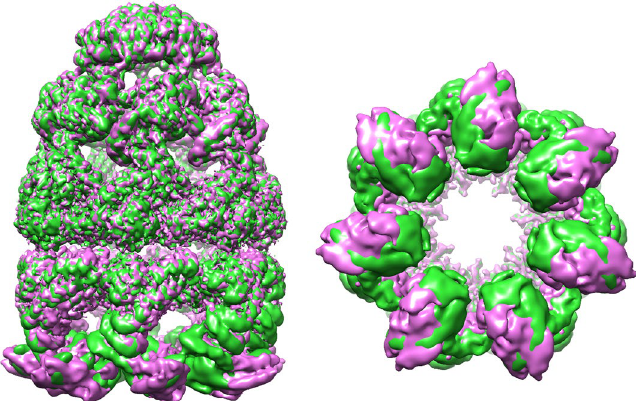
Figure 2. Cryo-EM density maps of the “tight” conformation (green) and the “wide” conformation